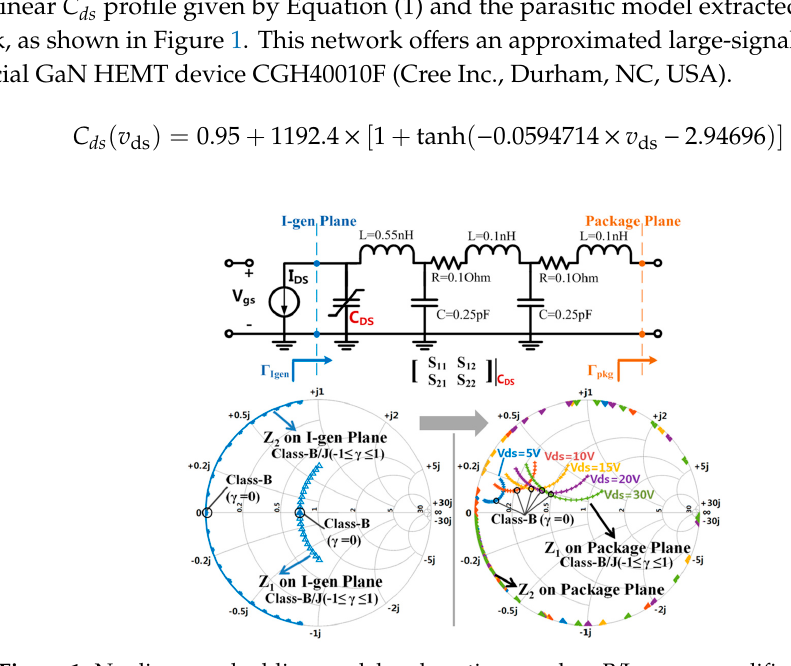
Figure 1. Nonlinear embedding model and continuous class-B/J power amplifier (PA) loads.